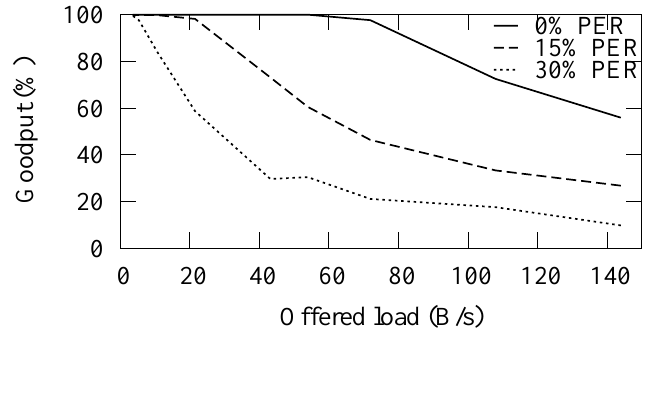
Figure 22. The effect of network load to the goodput in TUTWSN using the reliable data forwarding.